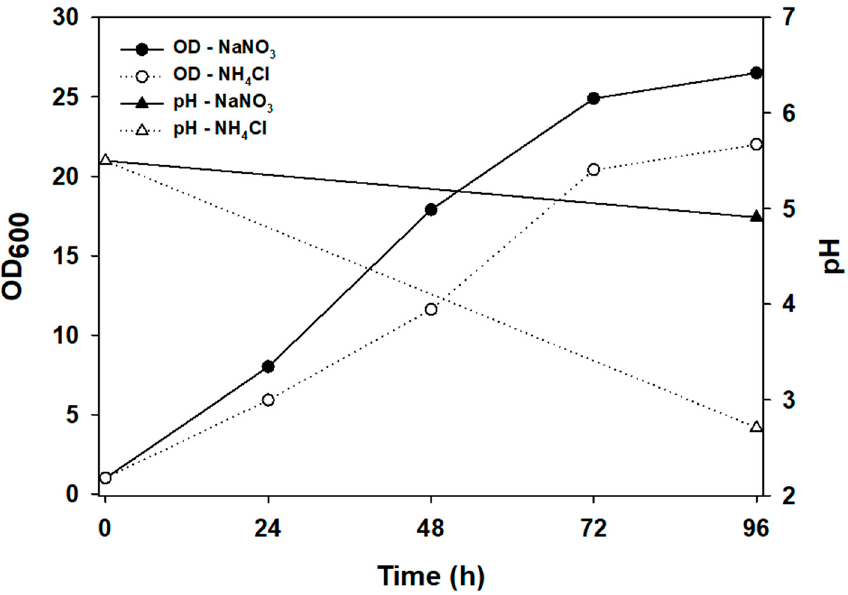
Figure 2. Effects of cell growth and pH change on the different nitrogen sources. Glucose (30 g/L) was used as the sole carbon source at a C/N of 40 in flask culture. Initial pH and rotation speed were 5.5 and 180 rpm, respectively.